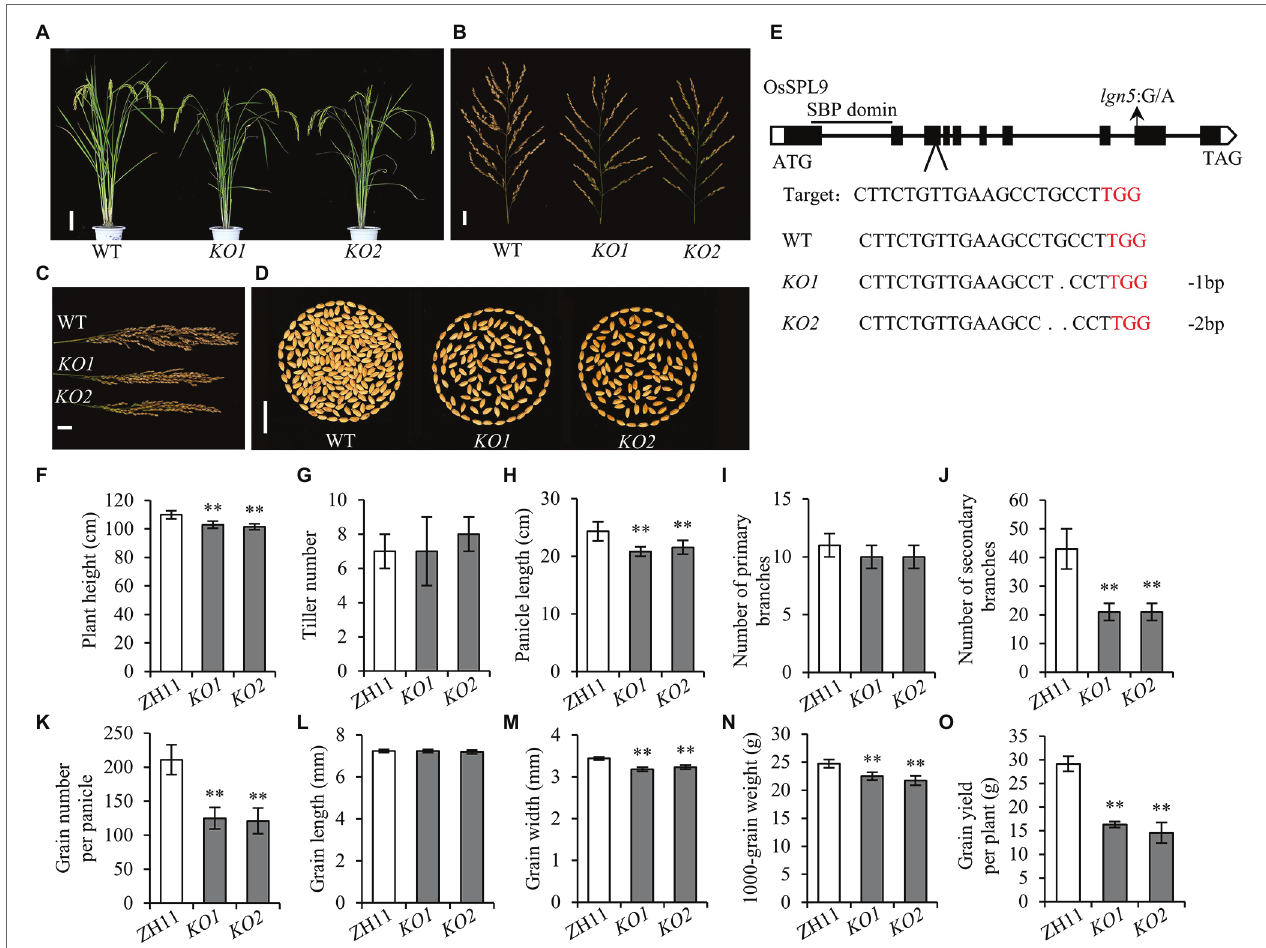
FIGURE 2 | Phenotypic comparison of wild type and CRISPR mutants. (A) Plant morphology of wild type and CRISPR mutants. Scale bar: 10 cm. (B) Panicle morphology of wild type and CRISPR mutants. Scale bar: 2 cm. (C) Panicles of wild type and CRISPR mutants. Scale bar: 2 cm. (D) Comparison of GNP between wild type and CRISPR mutants. Scale bar: 2 cm. (E) Schematic diagram of the target site in OsSPL9 and the target sequence alignment of wild type and CRISPR mutants. The number of altered bases is indicated on the right; “ − ” indicates deleted bases. ATG, start codon; TAG, stop codon; the arrow shows the mutant site in lgn5 . (F–O) Agronomic traits in wild type and CRISPR mutants. Data are given as means ± SD of five biological replicates. ** indicates p < 0.01 by the Student’s t